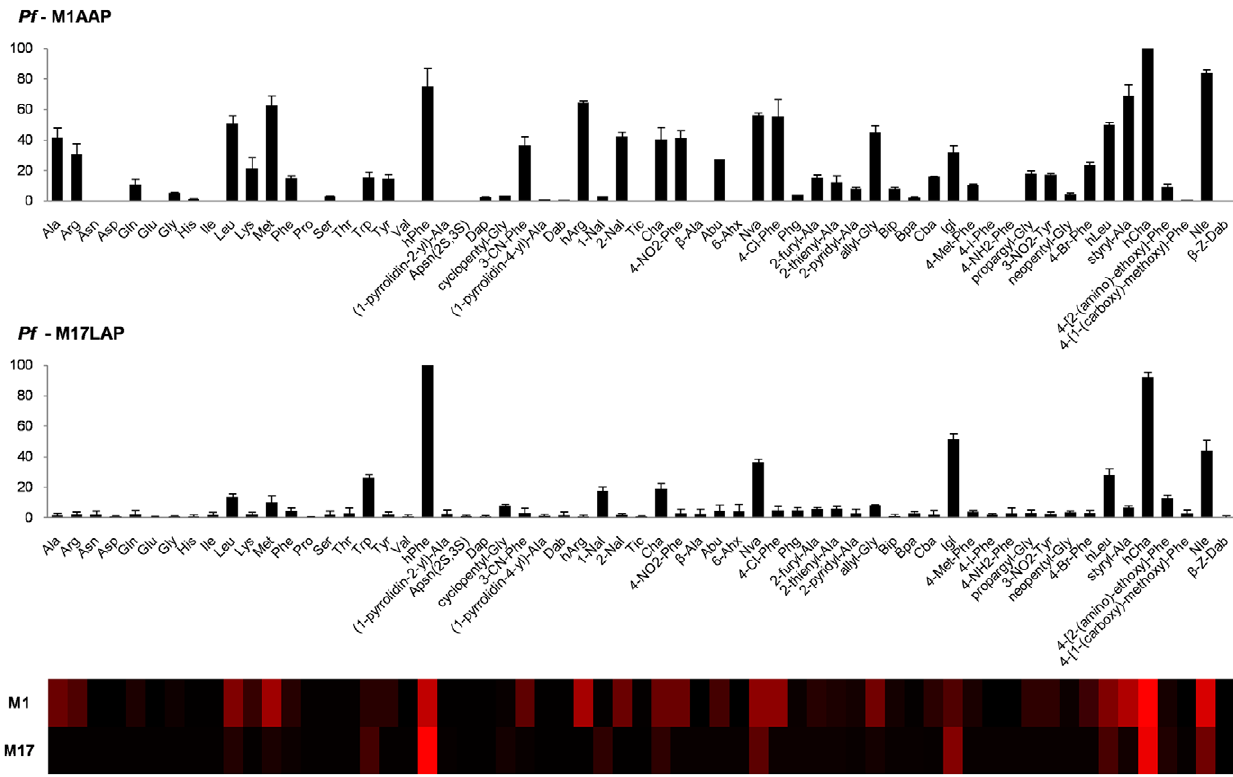
Figure 3. Individual preferences in S1 pocket of Pf M1AAP and Pf M17LAP enzymes toward natural and unnatural amino acid substrates. Screening of the 61-membered natural and unnatural amino acid library. Enzyme activity was monitored using an fmax multi-well fluorescence plate reader (Molecular Devices) at excitation wavelength of 355 nm and an emission wavelength of 460 nm. The x-axis represents the abbreviated amino acid names (for full name and structure see Figure S1). The y-axis represents the average relative activity expressed as a percent of the best amino acid. In the heat map view the most preferred positions are displayed in bright red, whereas a complete lack of activity is in black, with intermediate values represented by intermediate shades of red.